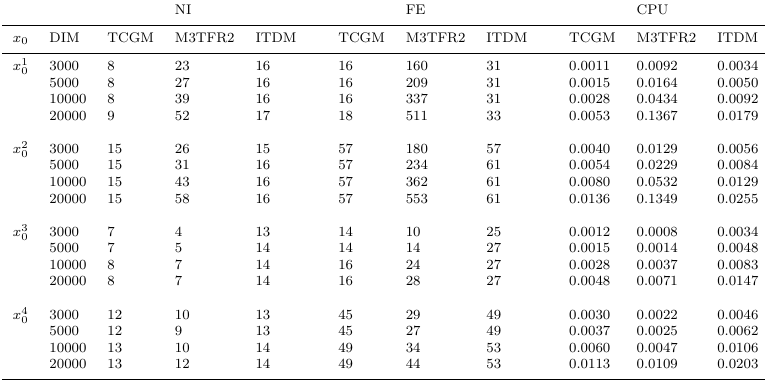
Table 8. Numerical results of Problem 8.